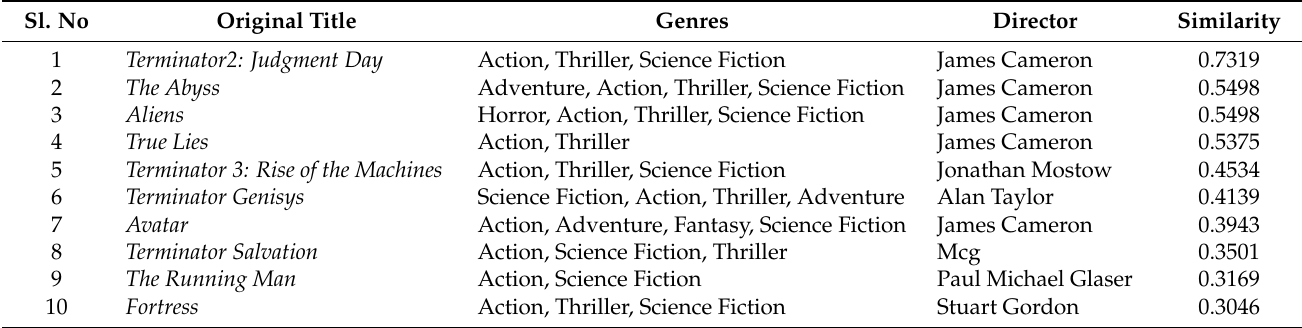
Table 7. Similar movies to the movie The Terminator .